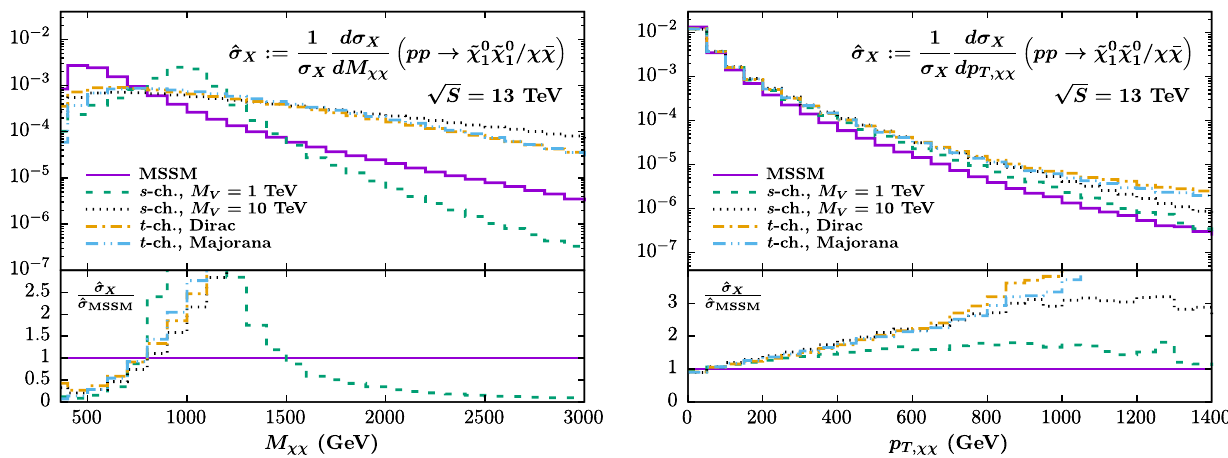
Fig. 11 Invariant mass (left) and the transverse momentum distribution (right) of the DM-pair system at NLO+PS accuracy. The masses and parameters are chosen according to the ˜ w/ ˜ h parameter point of Fig. 7. The coloring of the lines follows the scheme introduced in Fig. 9